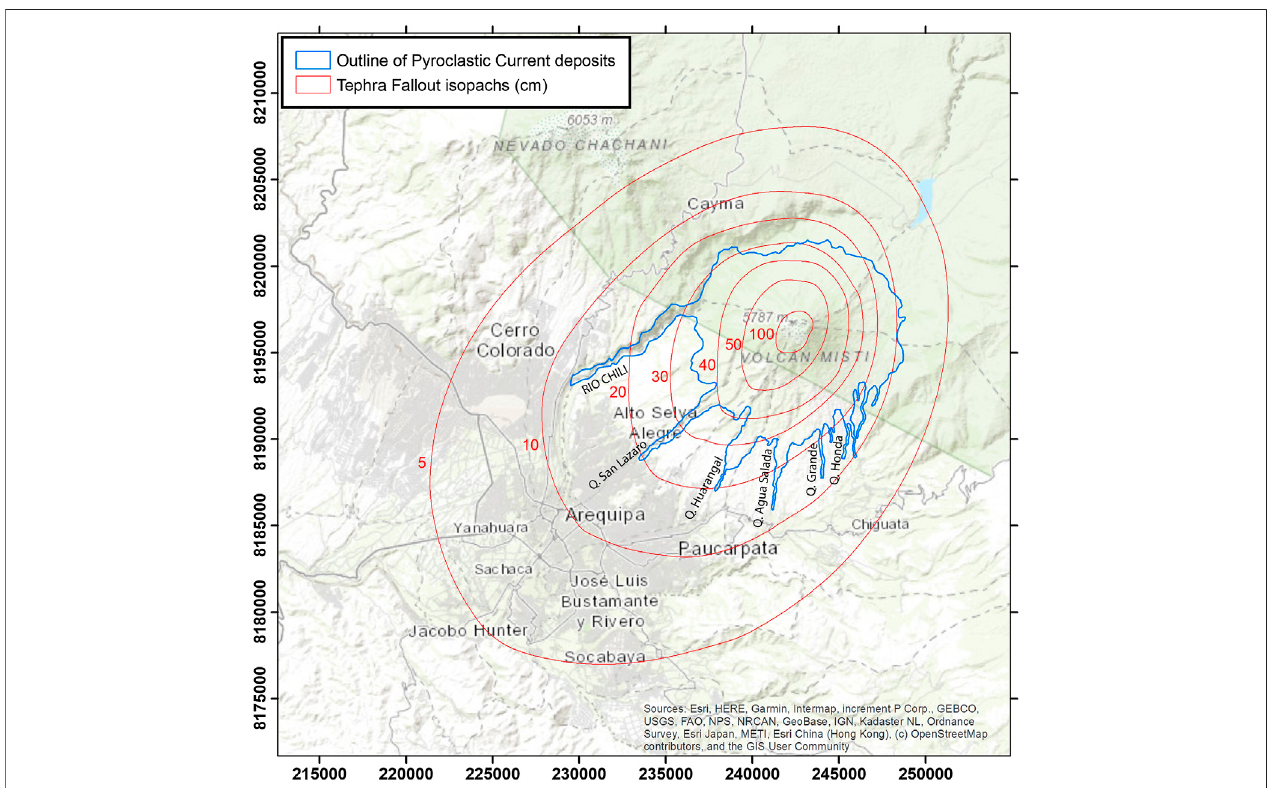
FIGURE 2 | Map of the 2070 cal yr BP eruptive deposits with pyroclastic current deposits outlined in blue and tephra fallout isopachs (in cm) delineated in red. Names of the studied valleys are indicated in black. Background map is from the ESRI World Topographic Map (source: ESRI). Modi fi ed from Cobeñas et al. (2012).